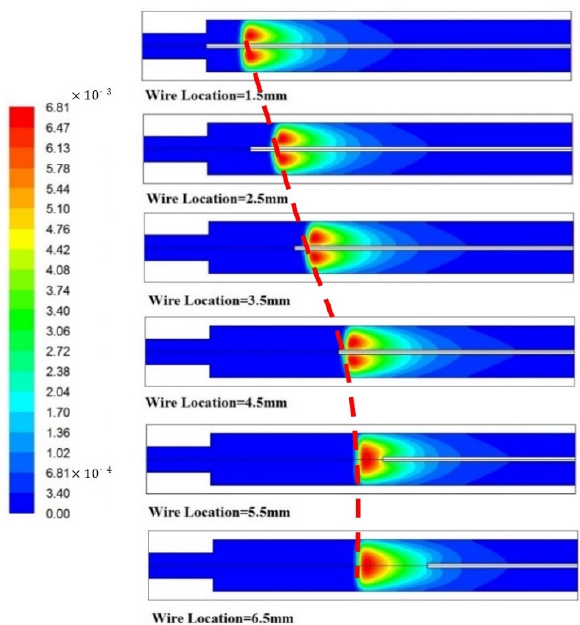
Figure 8. Contours of OH mass fraction in the micro-burner for different locations of the inserted wire.